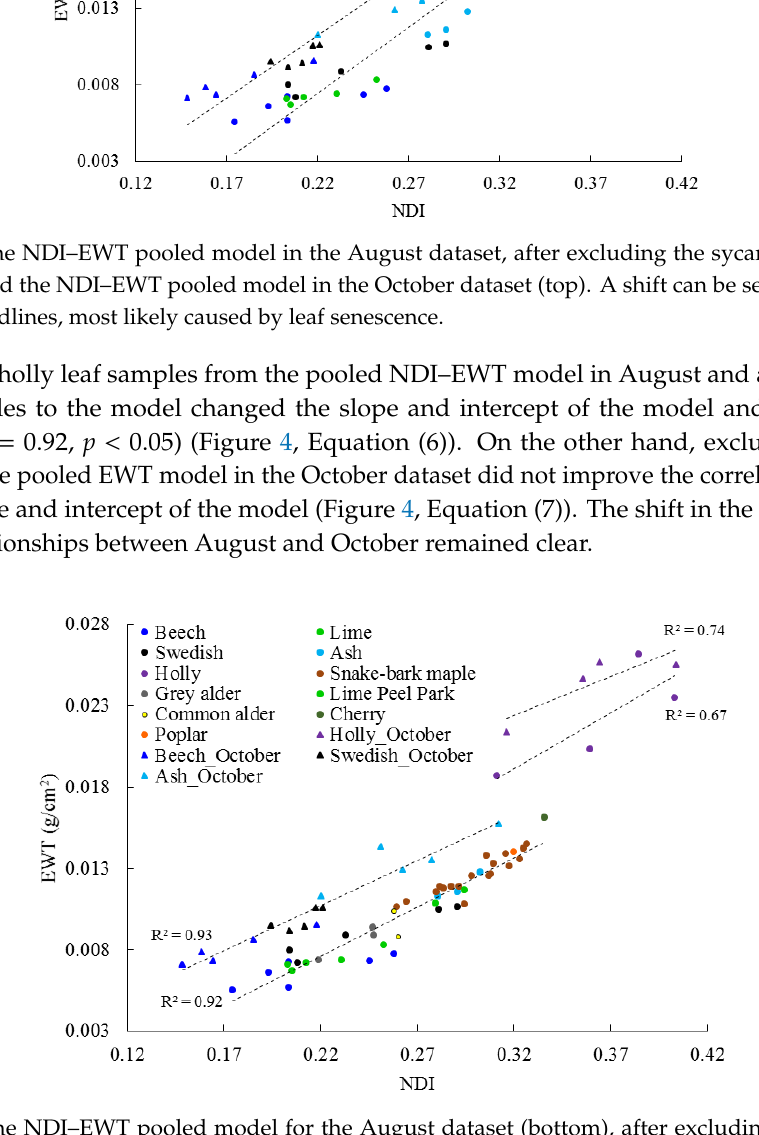
Figure 3. The NDI – EWT pooled model in the August dataset, after excluding the sycamore leaves (bottom), and the NDI – EWT pooled model in the October dataset (top). A shift can be seen between the two trendlines, most likely caused by leaf senescence.